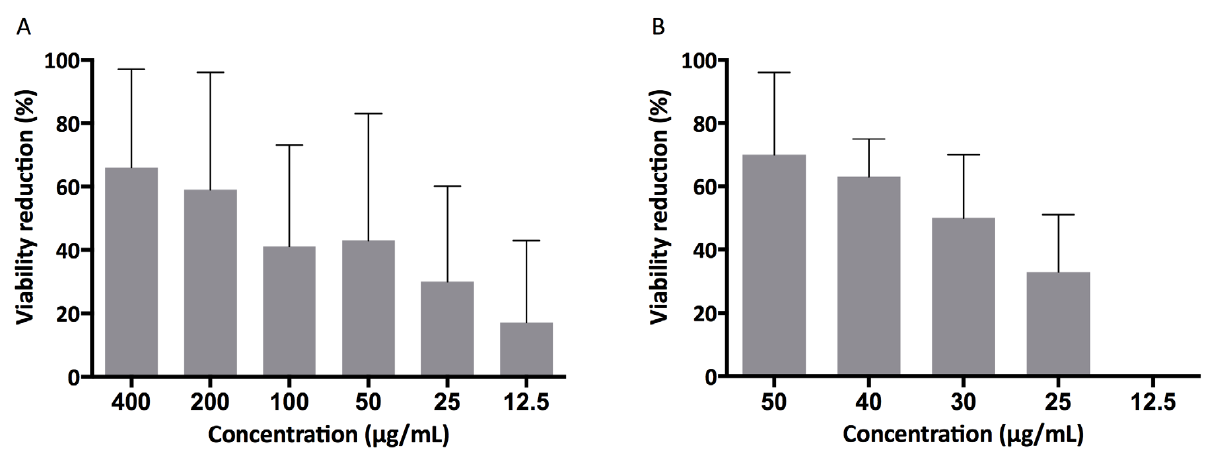
Figure 1. Effect of the investigated peptides against E. faecalis ATCC 29212 biofilm. Biofilm metabolic activity was determined by Alamar Blue assay after treatment with different concentrations of ( A ) KP and ( B ) L18R. Results are reported as percent reduction in biofilm viability as compared to untreated samples. Data are presented as mean ± SD of at least 3 independent experiments.